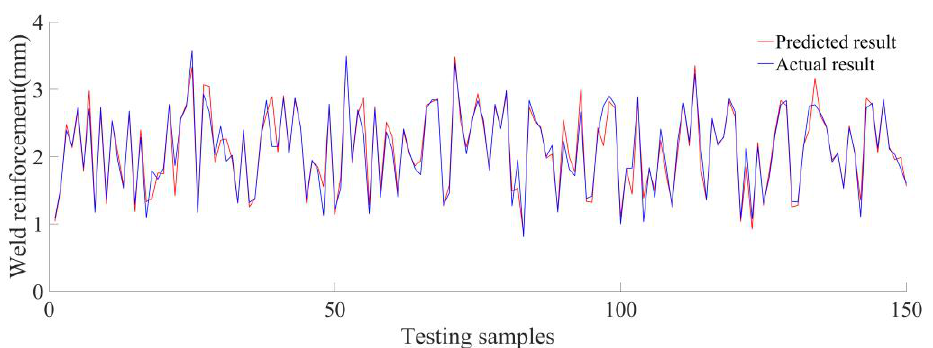
Figure 10. Predicted results of weld reinforcement.